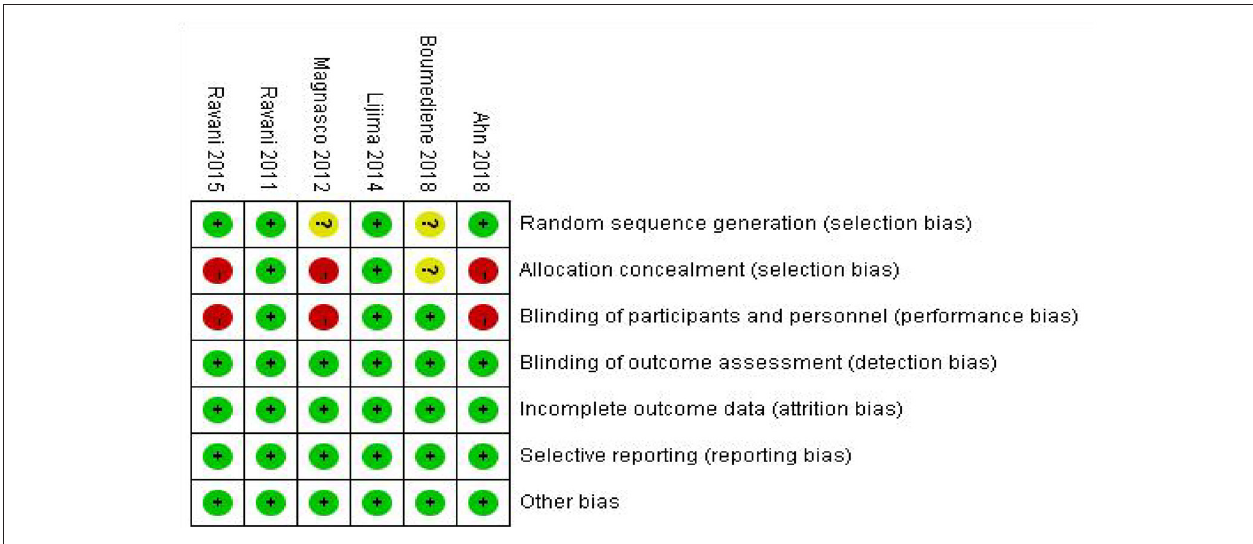
FIGURE 2 | Risk of bias summary.